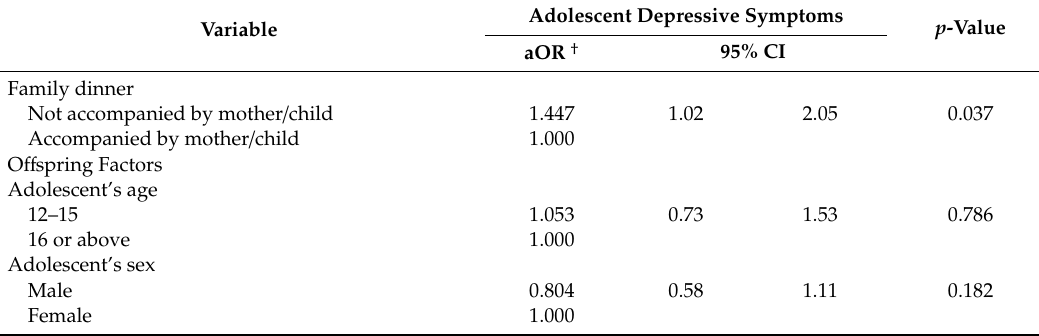
Table 2. Adjusted odds ratios for the association between maternal accompaniment at family dinners and depressive symptoms of